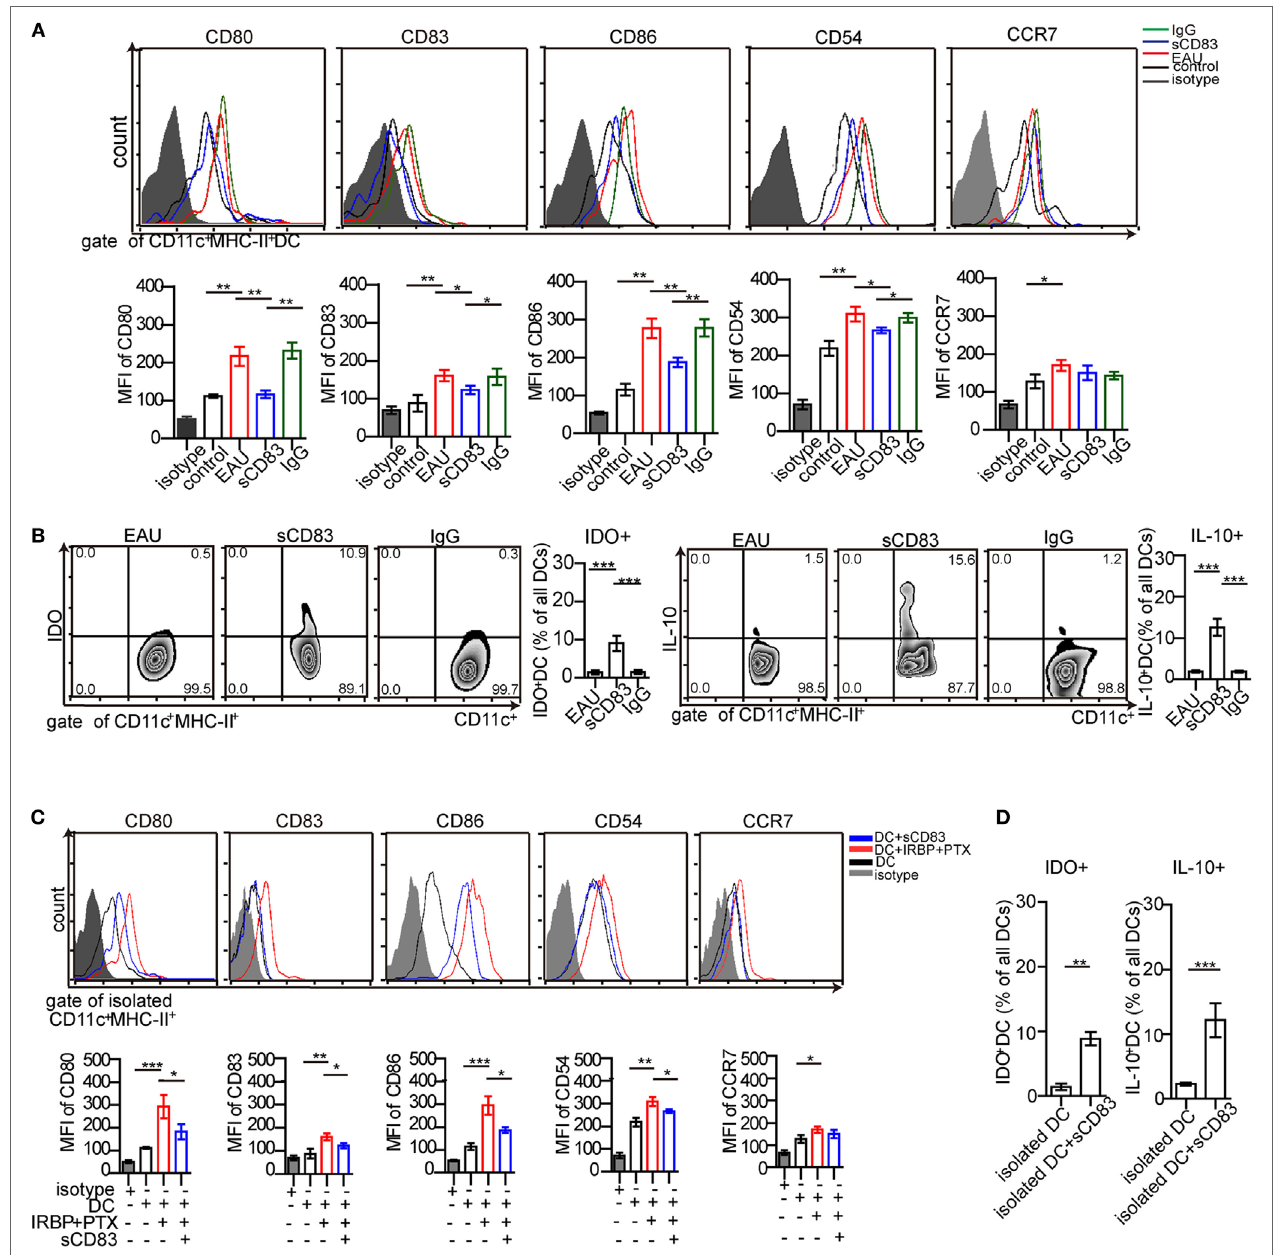
FigUre 5 | Soluble CD83 (sCD83) inhibits the maturation of dendritic cells (DCs) in vivo and in vitro . (a) Surface expressions of CD80, CD83, CD86, CD54, and CCR7 in splenic DCs were measured in controls, experimental autoimmune uveitis (EAU), sCD83-treated EAU, or IgG 1 -treated EAU mice. Gated on CD45 + CD11c + MHC-II + cells. (B) The percentage of IDO + DCs and IL-10 + DCs from EAU mice with or without sCD83/IgG 1 treatment. Data of (a,B) are from n = 20 in triplicates, mean ± SEM, one-way ANOVA LSD- t test. *** p < 0.001, ** p < 0.01, * p < 0.05. (c) Surface expression of CD80, CD83, CD86, CD54, and CCR7 on isolated DCs were analyzed by flow cytometry in vitro . DCs were isolated from EAU mice (DC), matured DC pulsed interphotoreceptor retinoid-binding protein peptide 1–20 (IRBP 1–20 ) and pertussis toxin (PTX) (DC + IRBP 1–20 + PTX), and additionally treated with sCD83 (DC + sCD83). n = 5, mean ± SEM, one-way ANOVA LSD- t test. *** p < 0.001, ** p < 0.01, * p < 0.05. (D) Flow cytometry analysis of IDO + and IL-10 + DCs with or without sCD83 treatment. n = 5; mean ± SEM, two-tailed Student’s t -test. *** p < 0.001, ** p < 0.01.